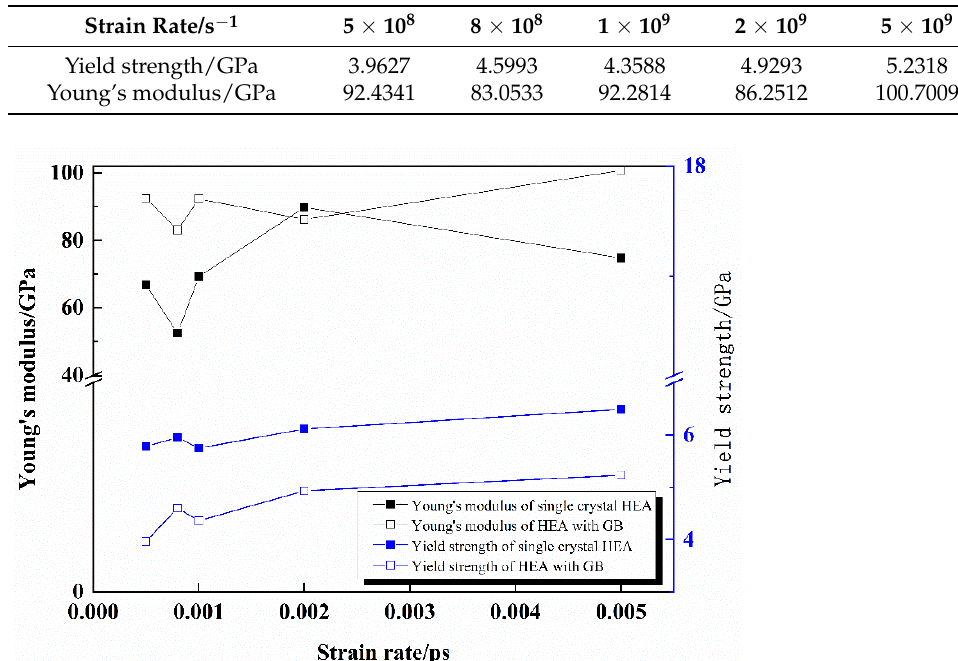
Table 2. Young’s modulus and yield strength of GB-HEA at different strain rates.